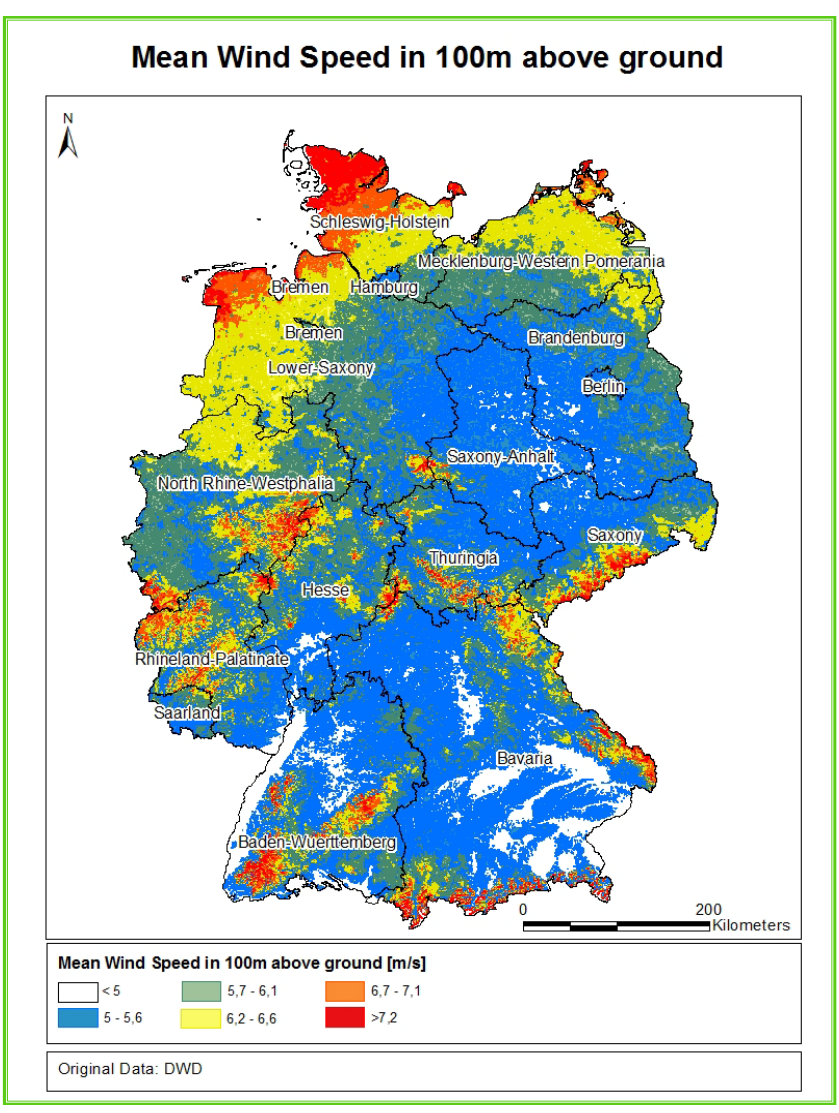
Figure 5. Mean wind speed in 100 m above ground in